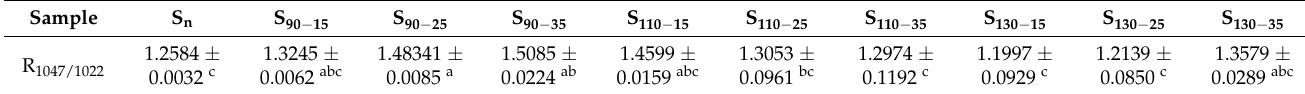
Means followed by different letters in the same line are significantly different at p < 0.05. S n indicates native HB flour; S 90 − 15 , S 90 − 25 , S 90 − 35 indicate that the heating temperature of HB flour is 90 ◦ C; S 110 − 15 , S 110 − 25 , S 110 − 35 indicate that the heating temperature of HB flour is 110 ◦ C; S 130 − 15 , S 130 − 25 , S 130 − 35 indicate that the heating